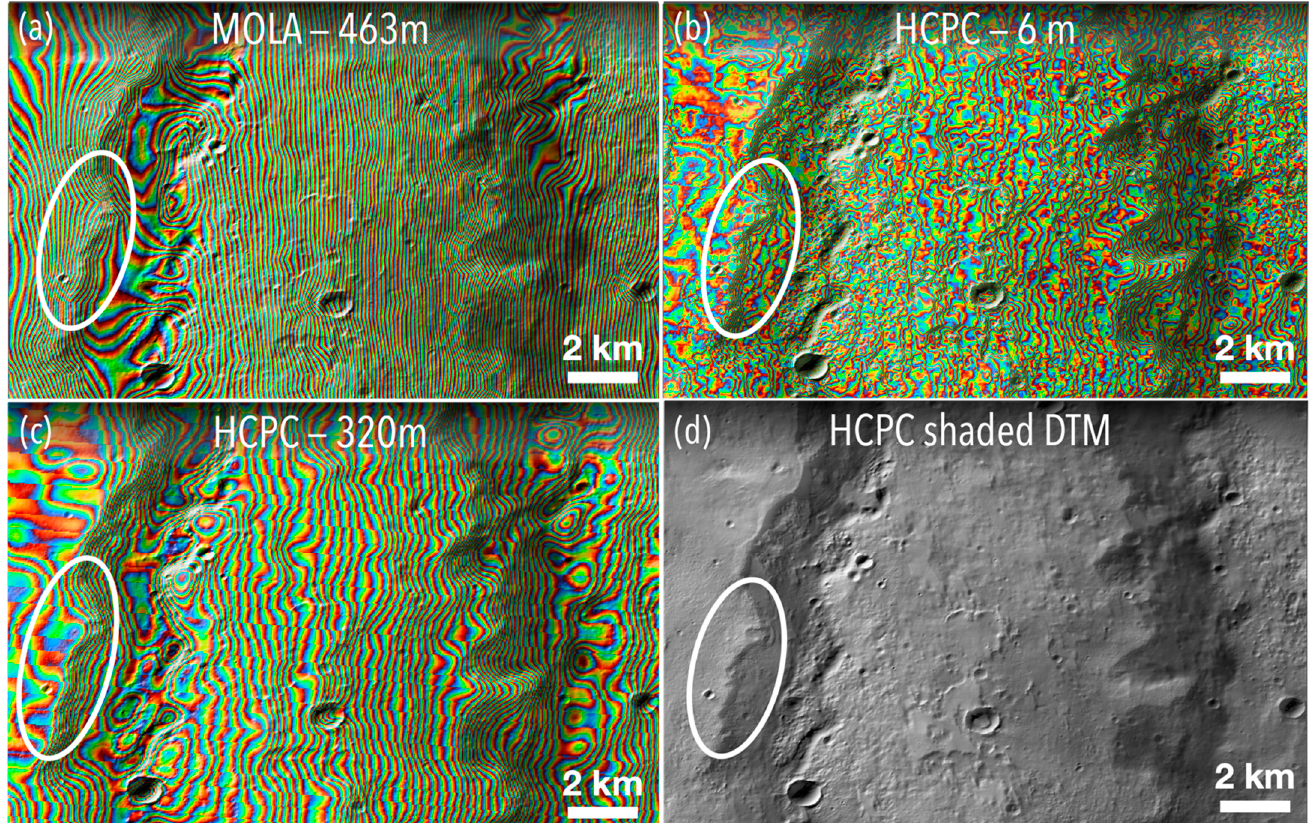
Figure 15. ( a – c ) Mapping of the across-track round-trip distance between the points of the DTMs and the spacecraft. The slant range was mapped modulo lambda using a cyclic color scale that can be directly linked to the evolution of the signal’s phase across track. The plateau that we want to correct by photoclinometry is located in the white circle. The areas where the phase is stationary are the areas where the radar signal reflects on, and the larger the area, the brighter the echo. ( a ) Range map in the MOLA DTM. ( b ) Range map in the 6m HCPC DTM. ( c ) Range map of the 320 m scale wavelet-transform of the HCPC DTM. ( d ) HCPC-shaded DTM to visualize the terrain details.